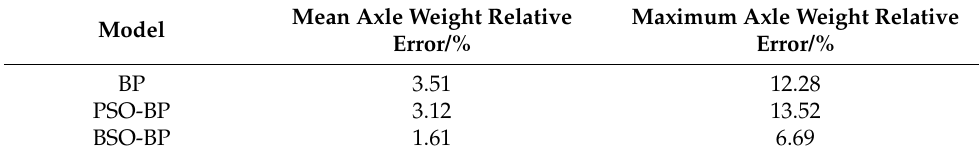
Table 3. Mean axle weight relative error and maximum axle weight relative error of three models.